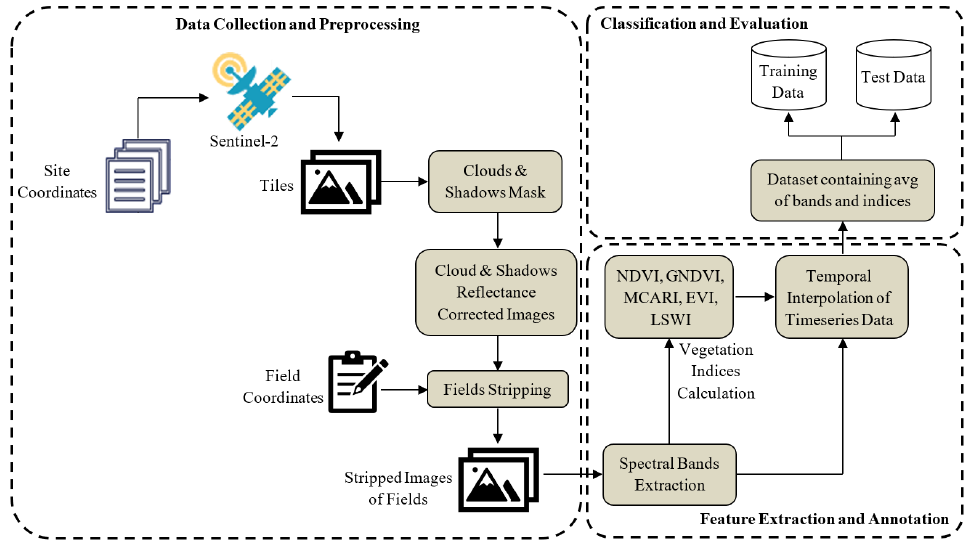
Figure 3. Pipeline for preparation of training and testing datasets used in experimental evaluation.